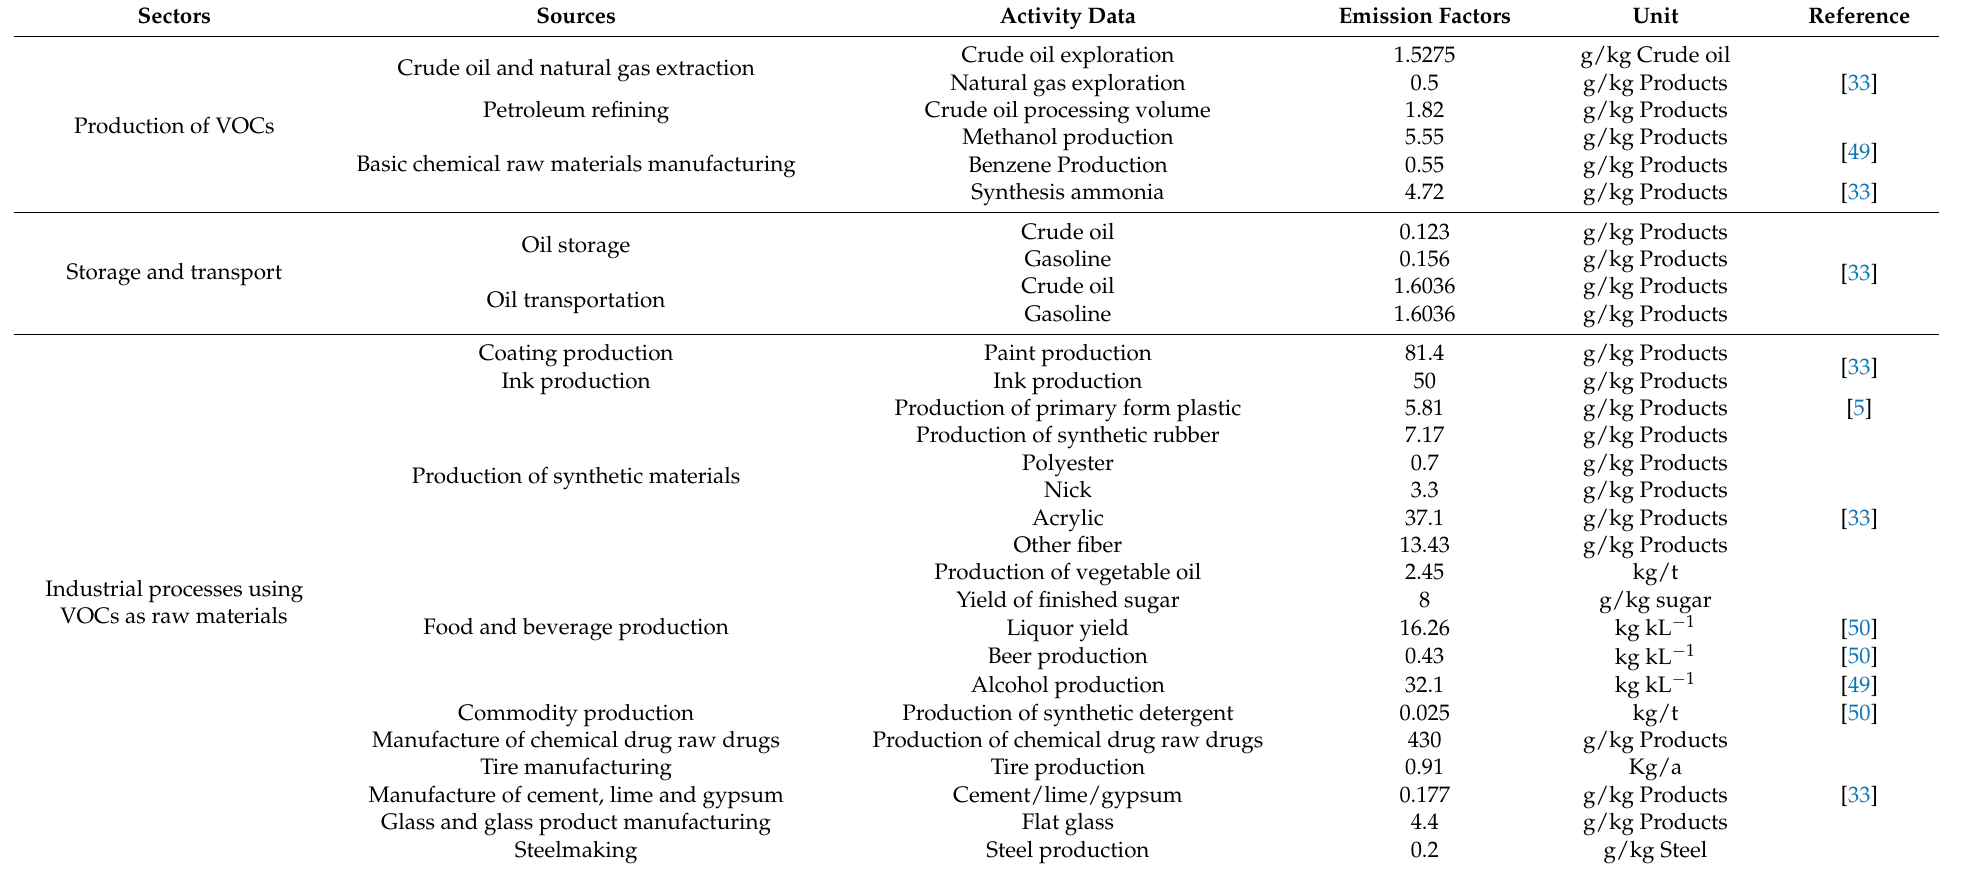
Table 2. Emission factors used in this